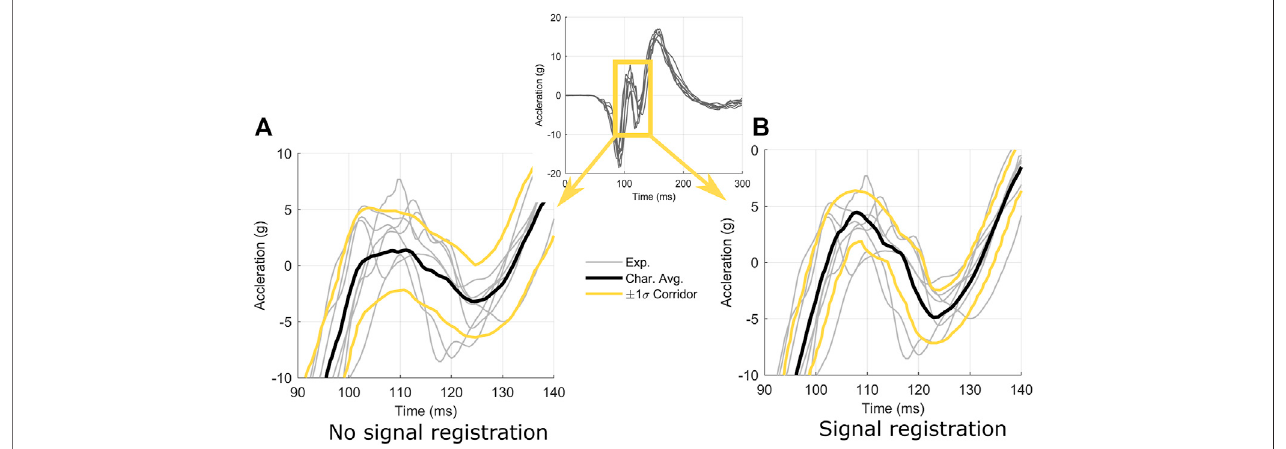
FIGURE13| Effectofsignalregistrationonthecharacteristicaverageandresponsecorridorsforheadaccelerationinthe z -direction.Signalregistration (B) utilized m (cid:2) 4 control points and produced a characteristic average that captured the underlying shape of the signals better than not performing signal registration (A)